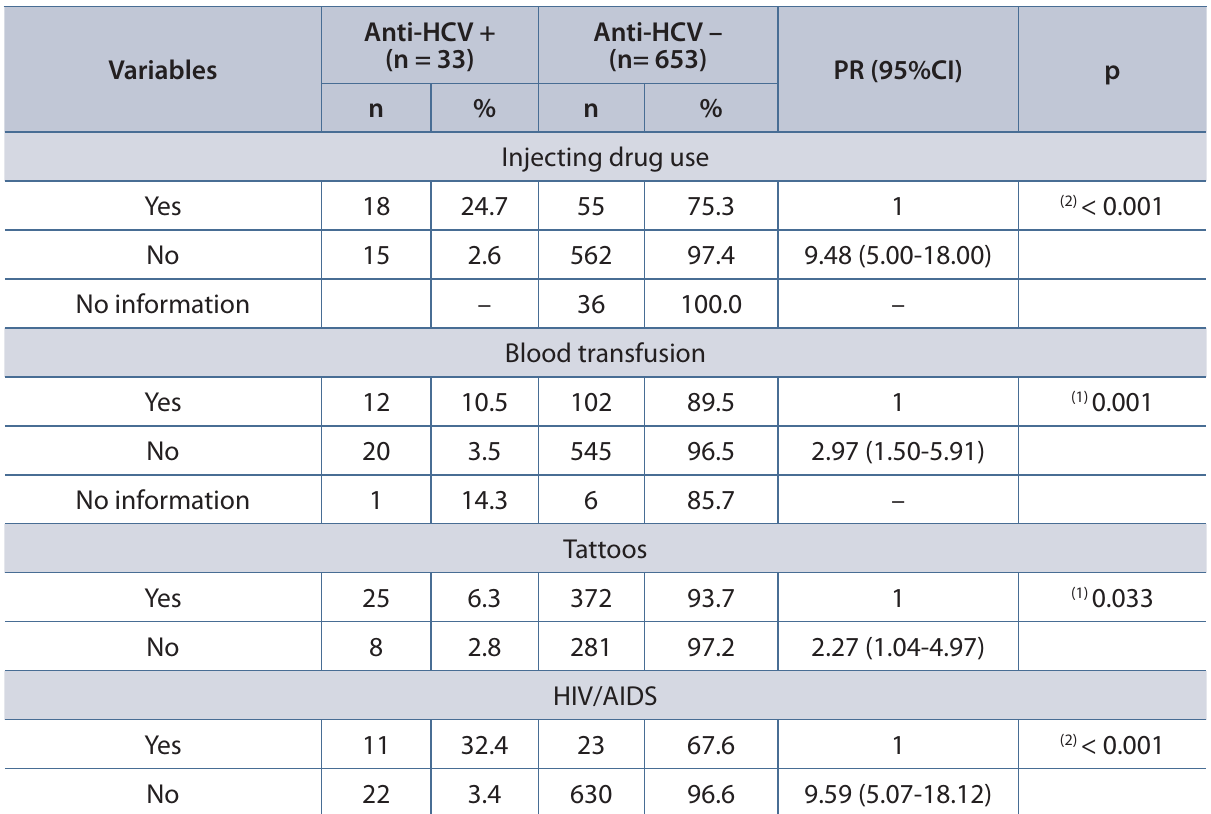
Table 2. Distribution of data from prisoners according to other factors associated with HCV, Campo Grande, Mato Grosso do Sul, Brazil in 2010 (n = 686)